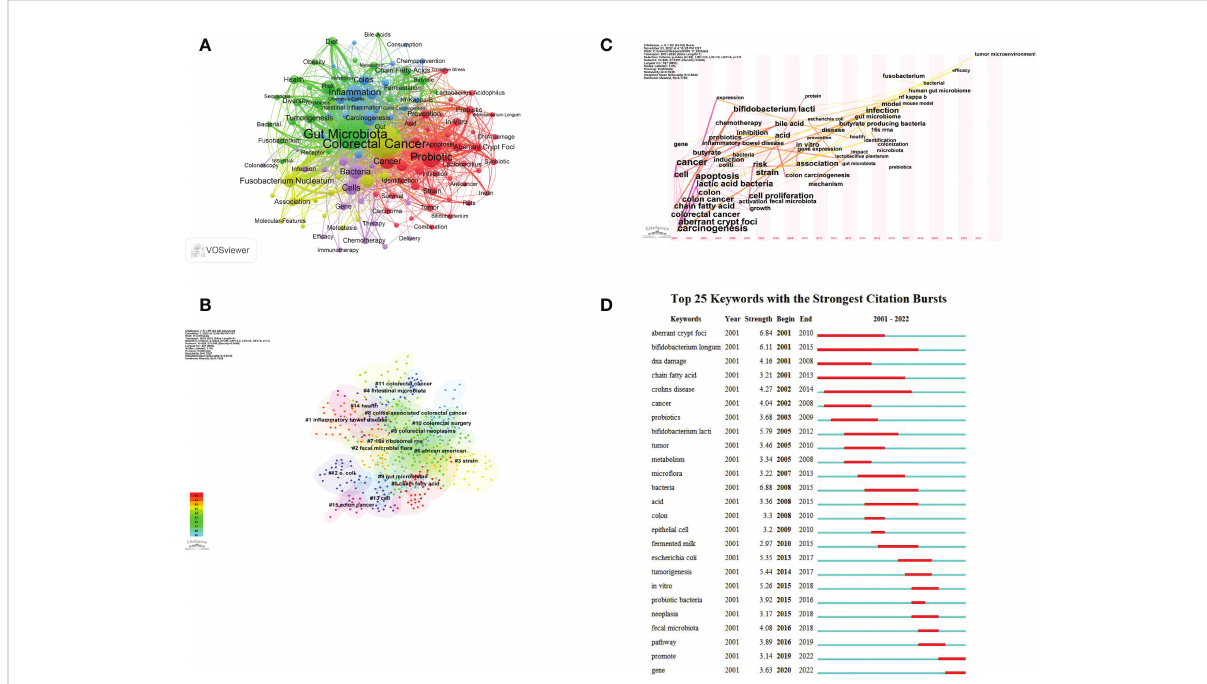
FIGURE 7 Keywords visualization related to gut microbiota and colorectal cancer research from 2001 to 2022. (A) The cooperation network of keywords in the fi eld. Dots represent keywords, with larger dots indicating the frequency of keywords, clusters are marked using different colors and links represent co-occurrence between keywords. (B) Keyword clustering analysis in this fi eld. Different colors represent different clusters. Each point represents a keyword and the number on the node represents the cluster the keyword belongs to. The different patterns represented a